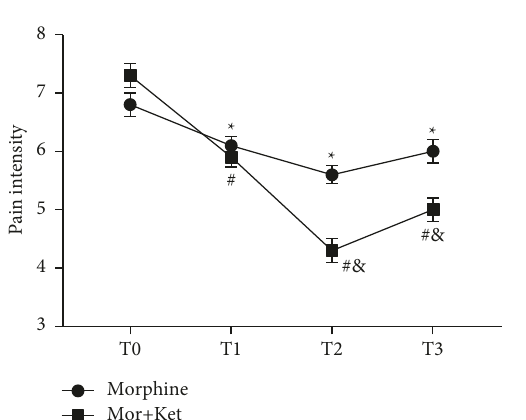
Figure 1: Changes in pain scores over the time between the two groups. T0, introduction time; T1, 2h; T2, 24h; T3, 48h, after treatment initiation. ∗ P < 0 . 05, # P < 0 . 05 vs. the T0 period. & P < 0 . 05 vs. the Mor (T2-T3 period)